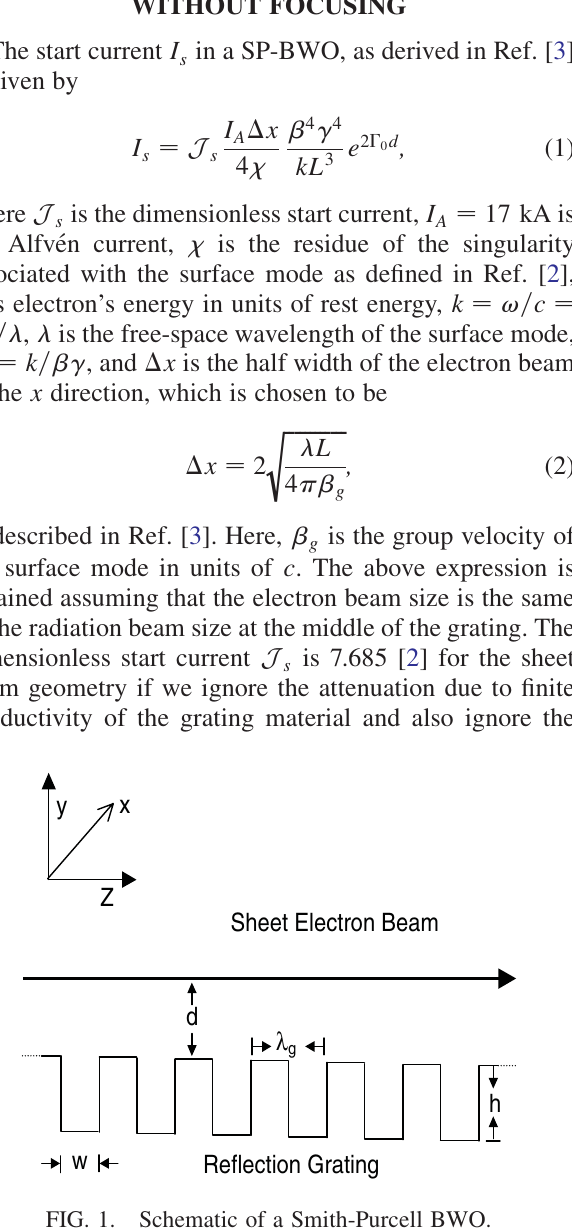
FIG. 1. Schematic of a Smith-Purcell